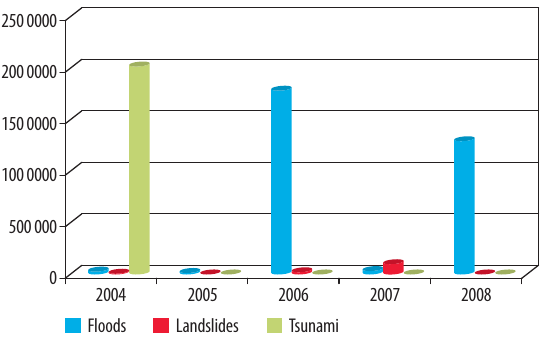
Figure 2. Number of families affected by